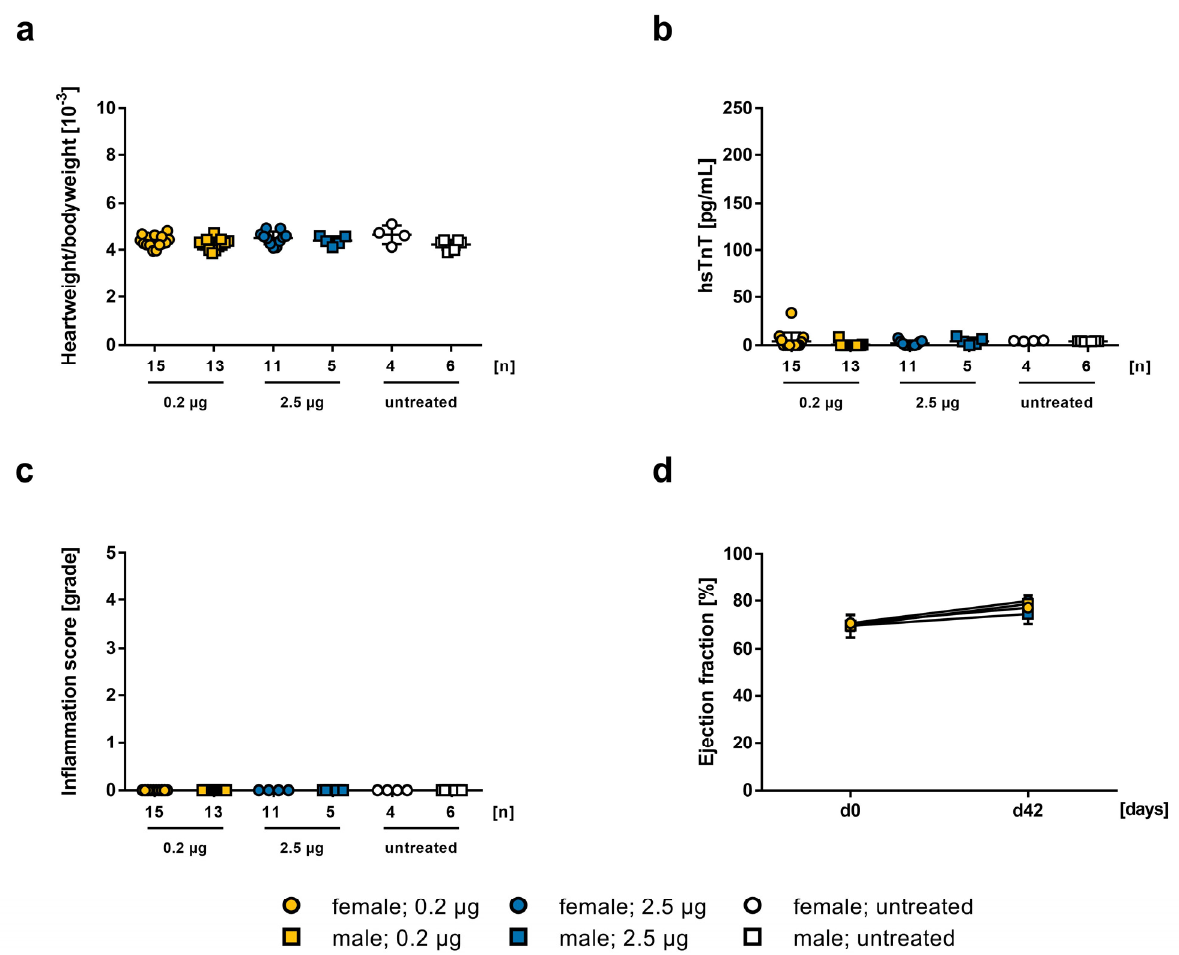
Figure 3. Comparison of 0.2 µ g and 2.5 µ g mRNA-vaccine on 5-weeks old A/J wt mice with untreated females (n = 4) and males (n = 6). Data is presented as a mean ± SEM. ( a ) Evaluation of heart weight to body weight ratio on day 42. ( b ) Comparison of hsTnT-values in mouse serum collected on day 42. ( c ) Histopathological examination of inflammation score in grades in HE stained heart sections on day 42, evaluated by two independent investigators. ( d ) Echocardiographic examination of ejection fraction using M-mode on day 0 and day 42.